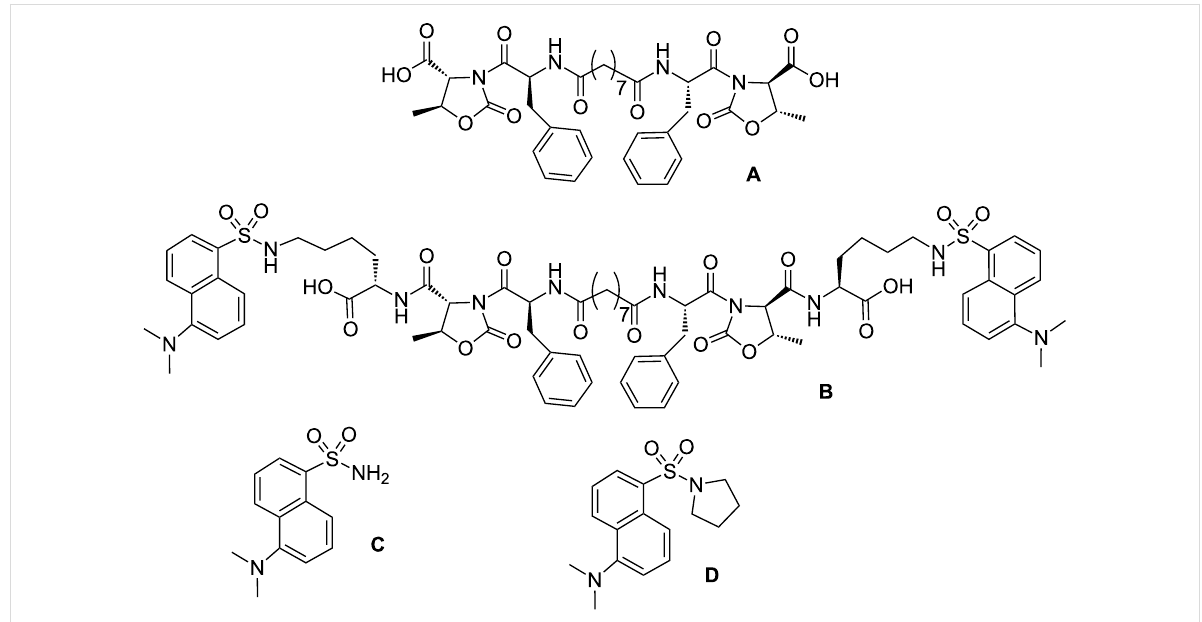
Figure 1: Chemical structure of the LMWHGs A and B and of the fluorescent moieties C and D described in this work.